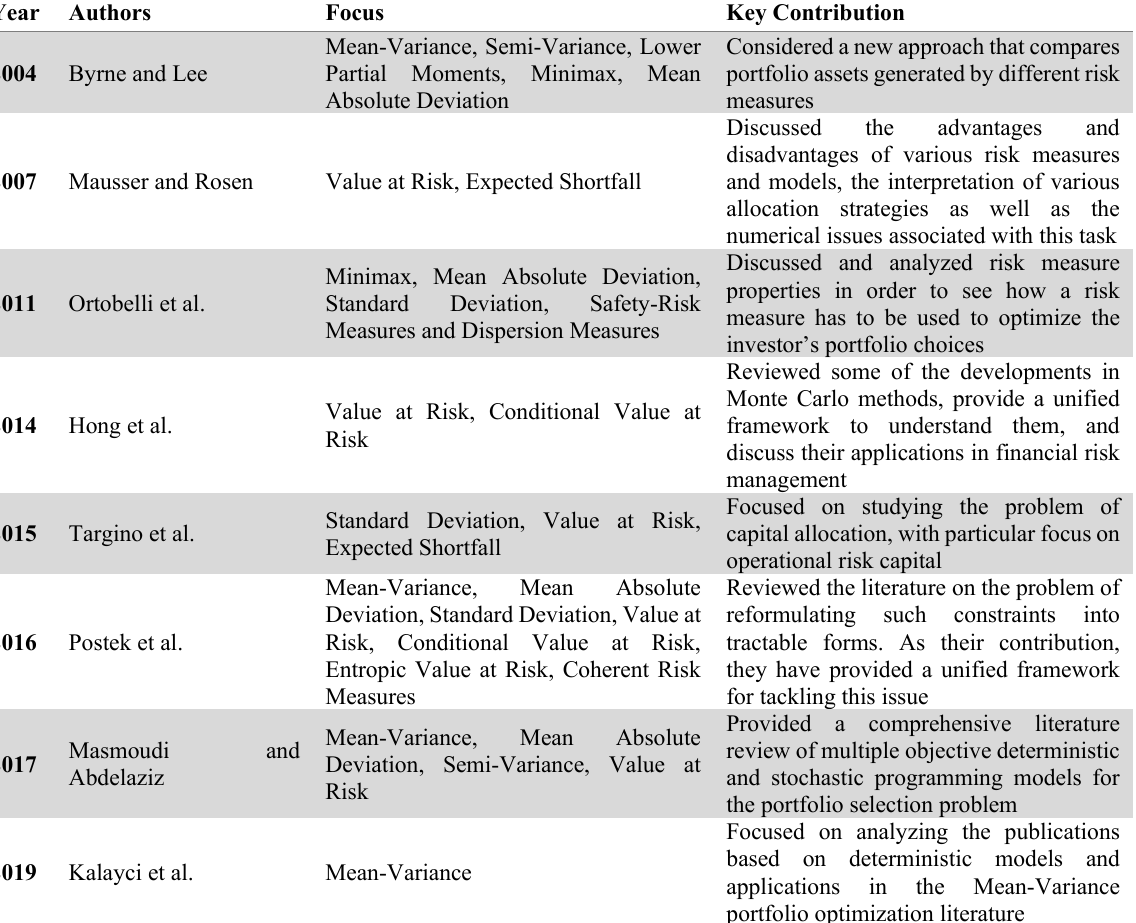
The Risk Measures for Portfolio Optimization - A Selection of Previous